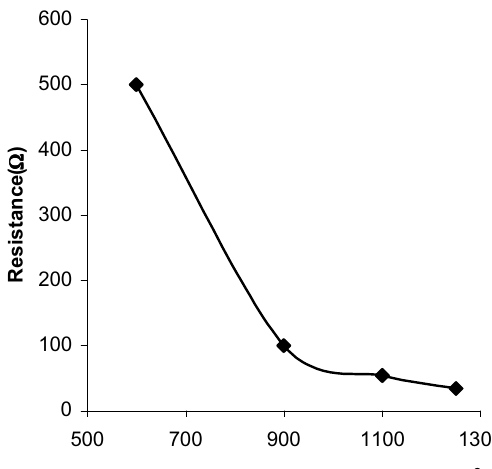
Figure 2. The paste resistances at different sintering temperatures in